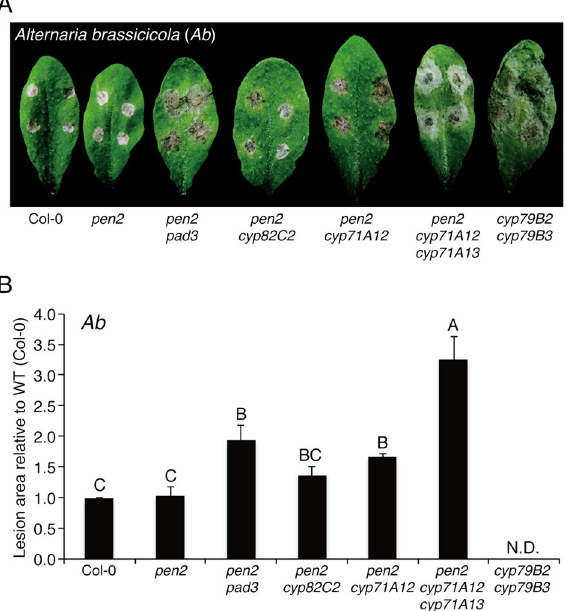
Figure 1. PAD3 and CYP71A12 are involved in the immunity of Arabidopsis against the necrotrophic pathogen Alternaria brassicicola ( Ab ). ( A ) Lesion development caused by Ab on Arabidopsis mutant plants with defects in Trp metabolism pathways. Conidial suspensions (1 × 10 5 conidia/mL) of Ab were drop-inoculated onto mature leaves of 4–5-week-old plants. The photograph was taken at 4 days postinoculation (dpi). ( B ) Quantification of lesion development. Conidial suspensions of Ab were drop-inoculated onto tested plants. At 4 dpi, lesion areas were measured and the relative values to Col-0 (WT plants) were calculated. Means and standard deviations (SDs) were calculated from three independent experiments. The statistical significance of differences between means was determined by Tukey’s honestly significant difference (HSD) test. Means not sharing the same letter are significantly different ( P < 0.05). N.D., not